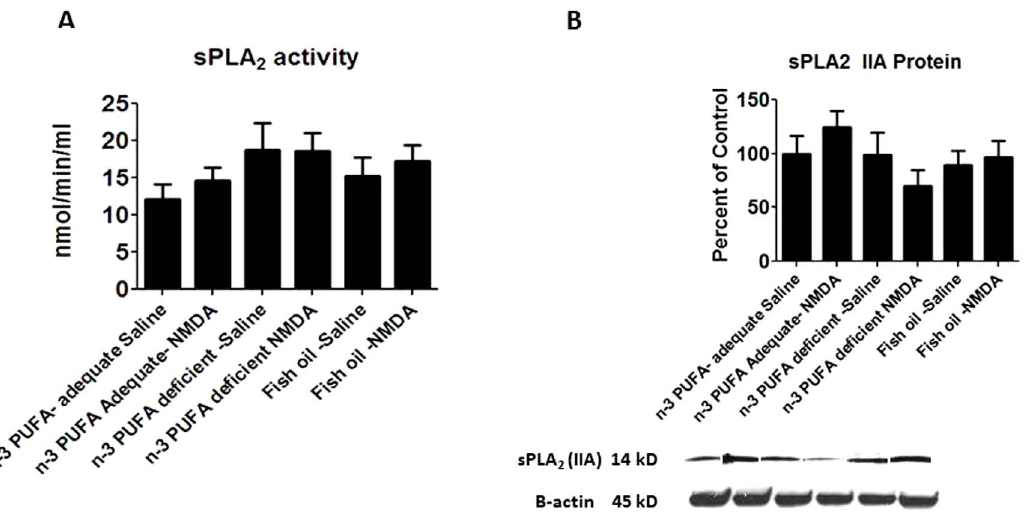
Figure 3. sPLA 2 activity and protein expression. Measured activity of A) sPLA 2 enzymes and B) sPLA 2 protein levels. Data are expressed as mean 6 SEM (n=5–6 per group for activity due to a negative activity value of 2 2.37 in the fish oil-NMDA group that was removed, and 5 per group for protein due to unquantifiable bands). Statistical significance is denoted by * p # 0.05, ** p , 0.01, *** p , 0.001.